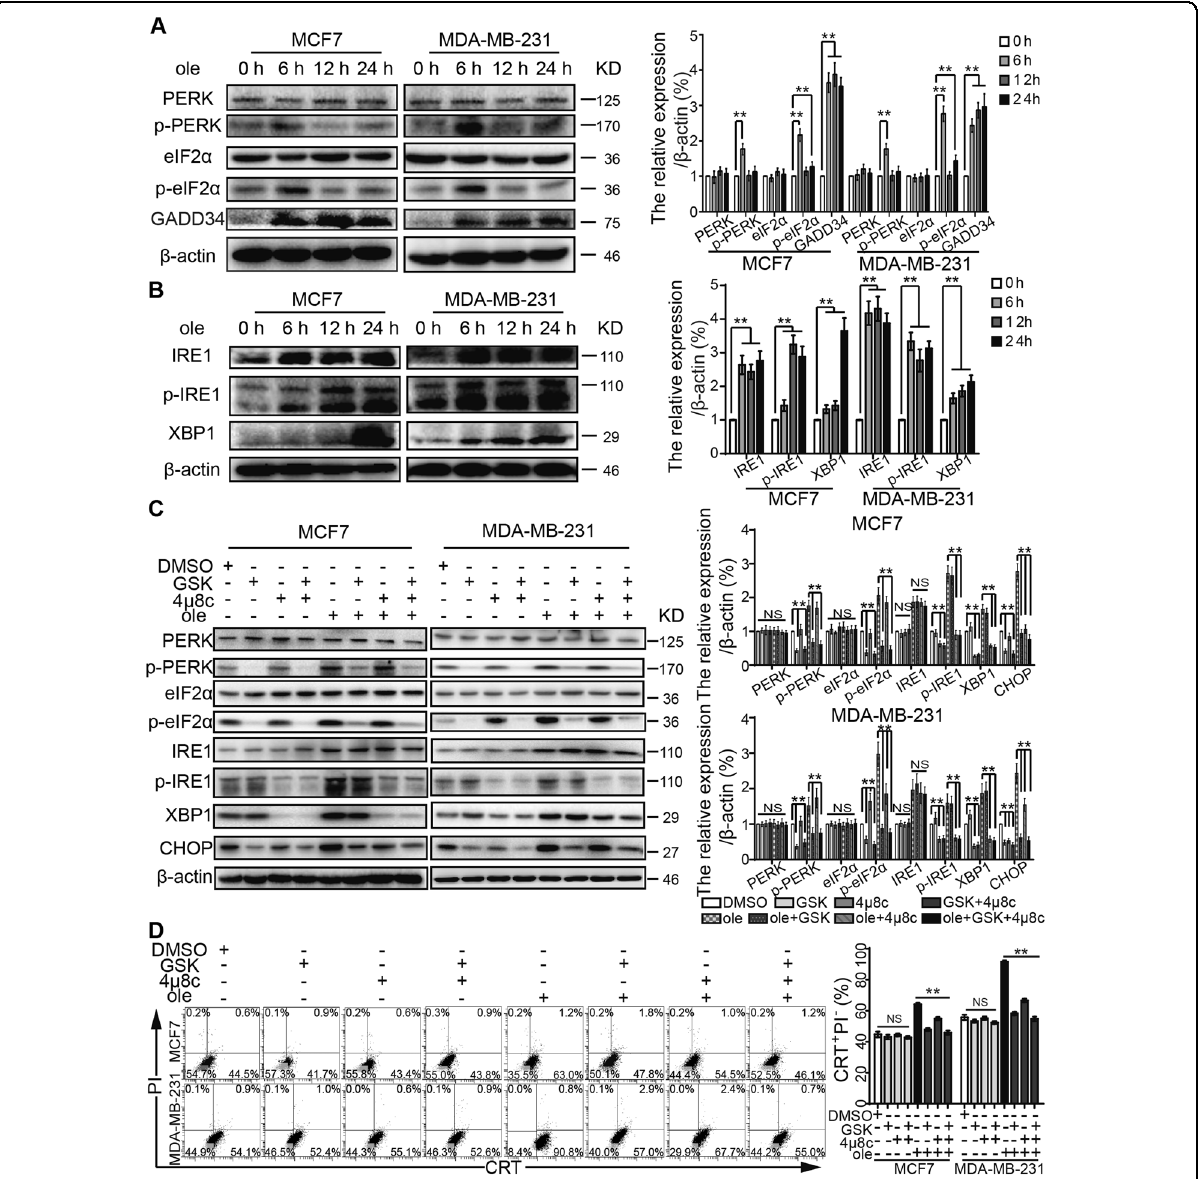
Fig. 8 Oleandrin induces breast cancer ER stress. A , B MCF7 and MDA-MB-231 cells were treated with oleandrin for 0, 6, 12, and 24 h. The protein expressions were analyzed by western blotting. C MCF7 and MDA-MB-231 cells were pretreated with the PERK inhibitor GSK2606414 at 6 μ M and the IRE1 inhibitor 4 μ 8C at 5 μ M for 12 h before treatment with oleandrin for further 6 h. β -actin was used as loading control. D Treated cells were stained with CRT and PI before detected by fl ow cytometry. The CRT-positive and PI-negative cells were showed in representative dot plots and quanti fi cation data. ** p < 0.01. ole, oleandrin; GSK,